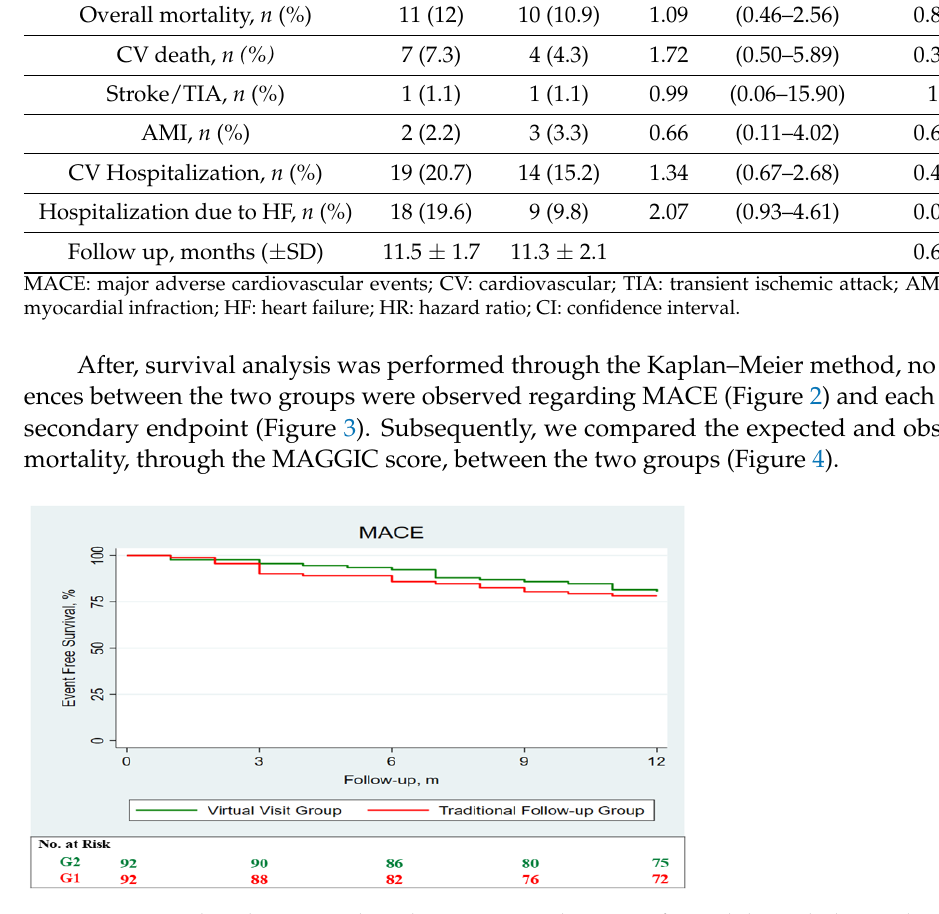
Figure 2. Survival analysis regarding the primary endpoint performed through the Kaplan–Meier method. Survival analysis demonstrates no differences in term of MACE, which is a composite of overall mortality, acute myocardial infarction, stroke, and hospitalization due to heart failure, between the two groups. G1 (red) is the group followed up through traditional in-person visits, while G2 (green) represents the virtual visit group.